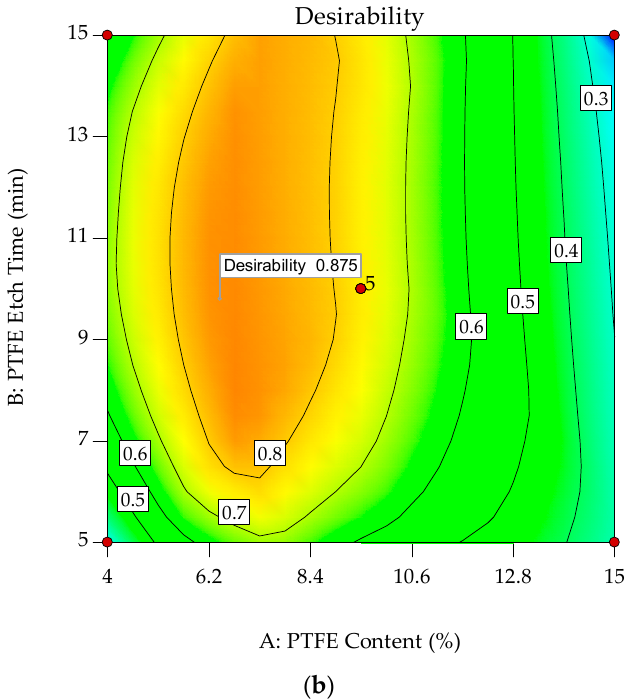
Figure 12. 3D response surface plot ( a ) with 2D contour plot; ( b ) of desirability function applied to multiple responses.